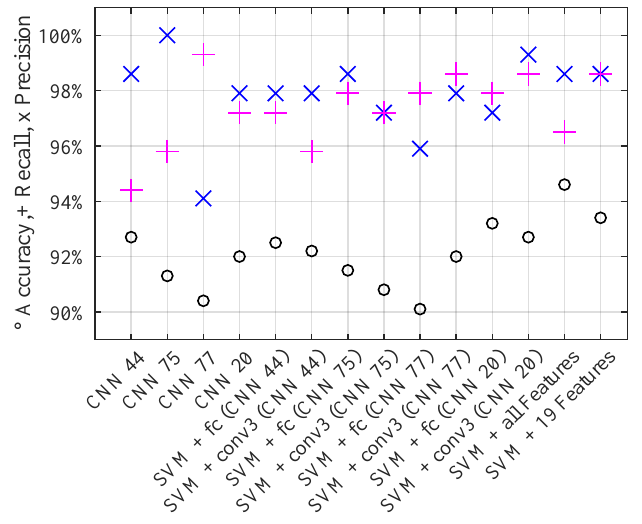
Figure 14. Performances of the models applied on the test